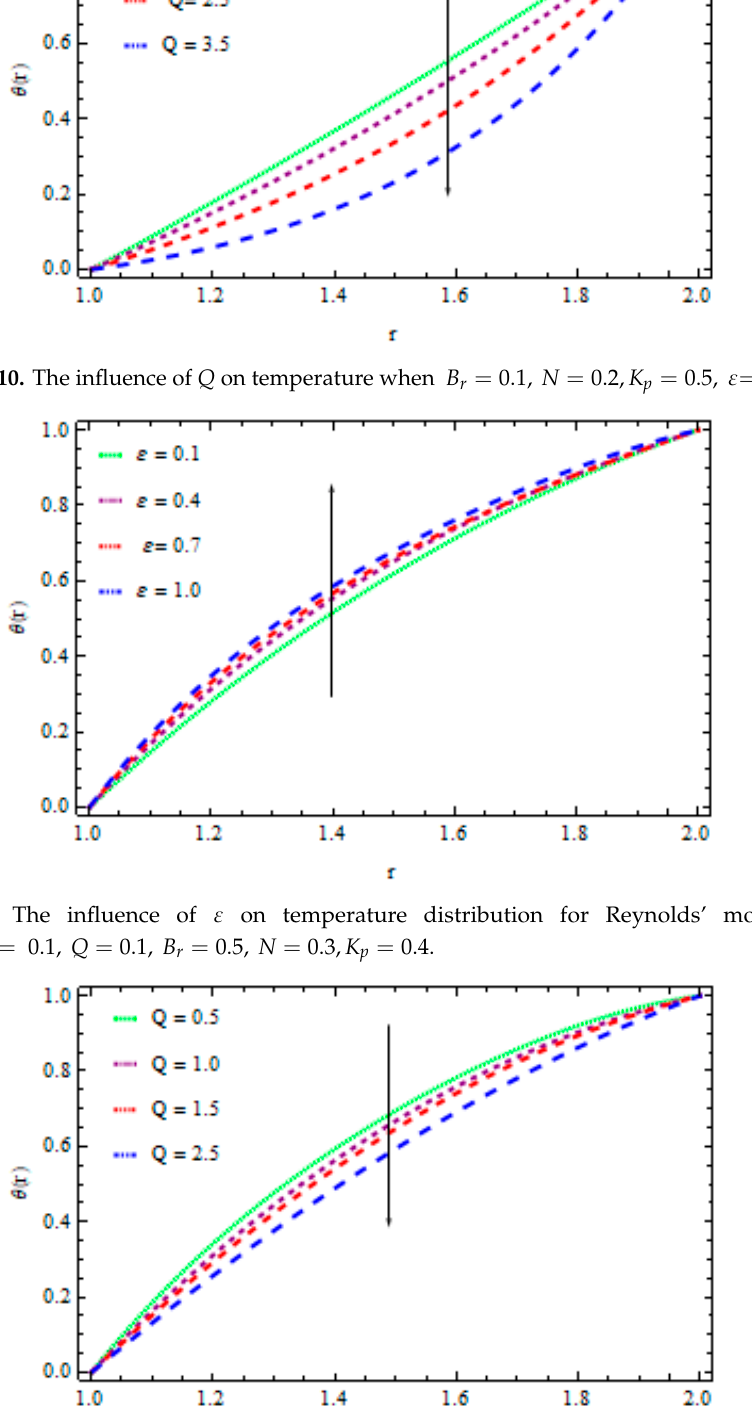
Figure 12. The influence of Q on temperature distribution in case of Reynolds’ model when, β = 2.1, m = 0.2, ε = 0.2, B r = 0.5, M = 0.6, N = 0.2, K p = 0